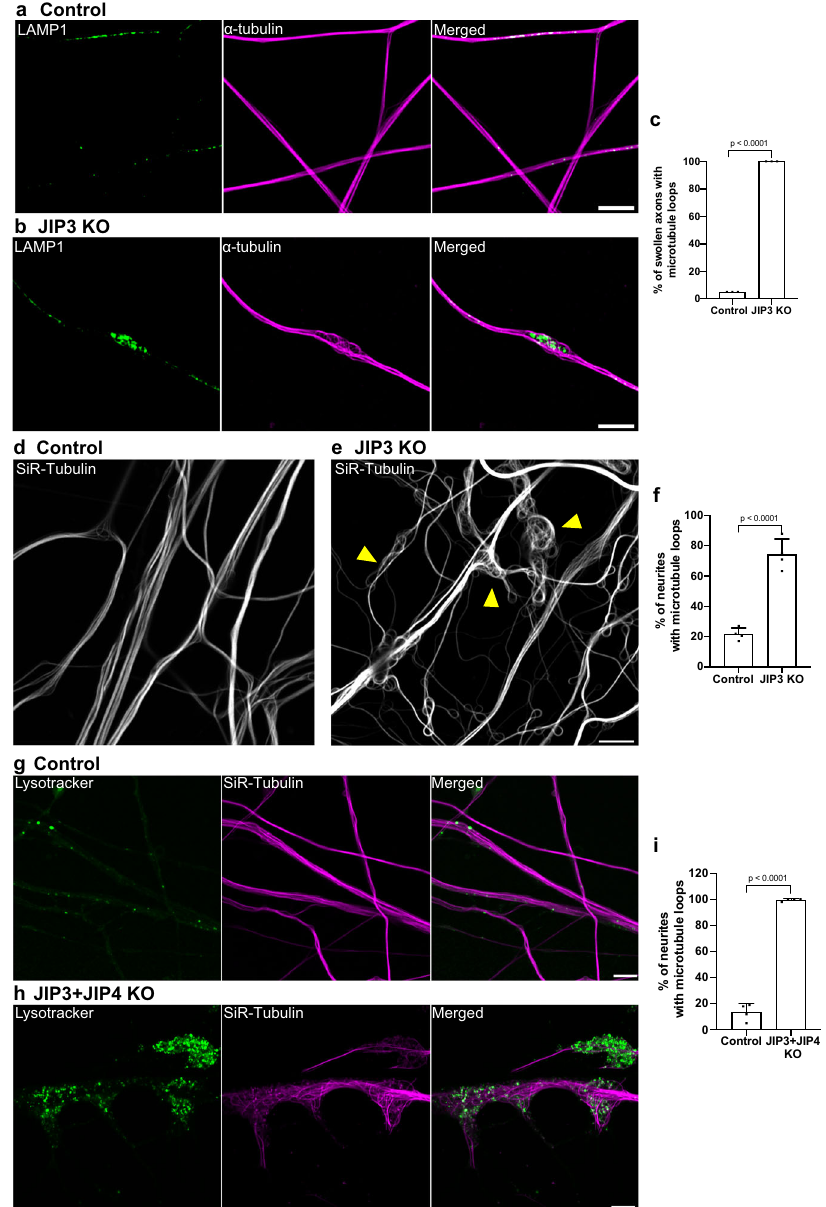
Fig. 2 Lysosome- fi lled axonal swellings in JIP3 KO axons coincide with sites of abnormal microtubule organization. a , b Airyscan imaging of LAMP1 (green) and α -tubulin (magenta) immuno fl uorescence in control and JIP3 KO i 3 Neurons (day 13), respectively (scale bars, 5 μ m). c Percentage of swollen axons with abnormally looped microtubules presented (mean ± SD; pooled from three independent experiments, ≥ 30 axons per experiment). d , e Control and JIP3 KO i 3 Neurons after 22 days of differentiation labeled for microtubules (SiR-tubulin; yellow arrowheads highlight examples of severe microtubule looping; scale bars, 5 μ m). f The percentage of neurites (mean ± SD) with disorganized microtubules pooled from four independent experiments of 22 day old cultures ( ≥ 34 neurites per experiment). g , h Lysotracker (green) and SiR-Tubulin (magenta) in control and JIP3 + JIP4 double KO i 3 Neurons (day 12) respectively (scale bars, 5 μ m). i The percentage of neurites (mean ± SD) with disorganized microtubules pooled from four independent experiments ( ≥ 22 neurites per experiment). p -values in all experiments were calculated using two-tailed Student ’ s t